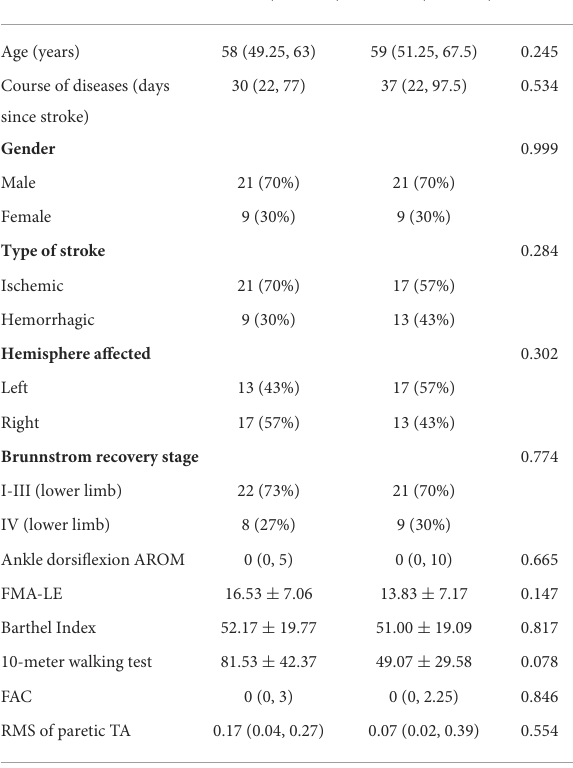
TABLE 1 Baseline demographics and clinical characteristics.